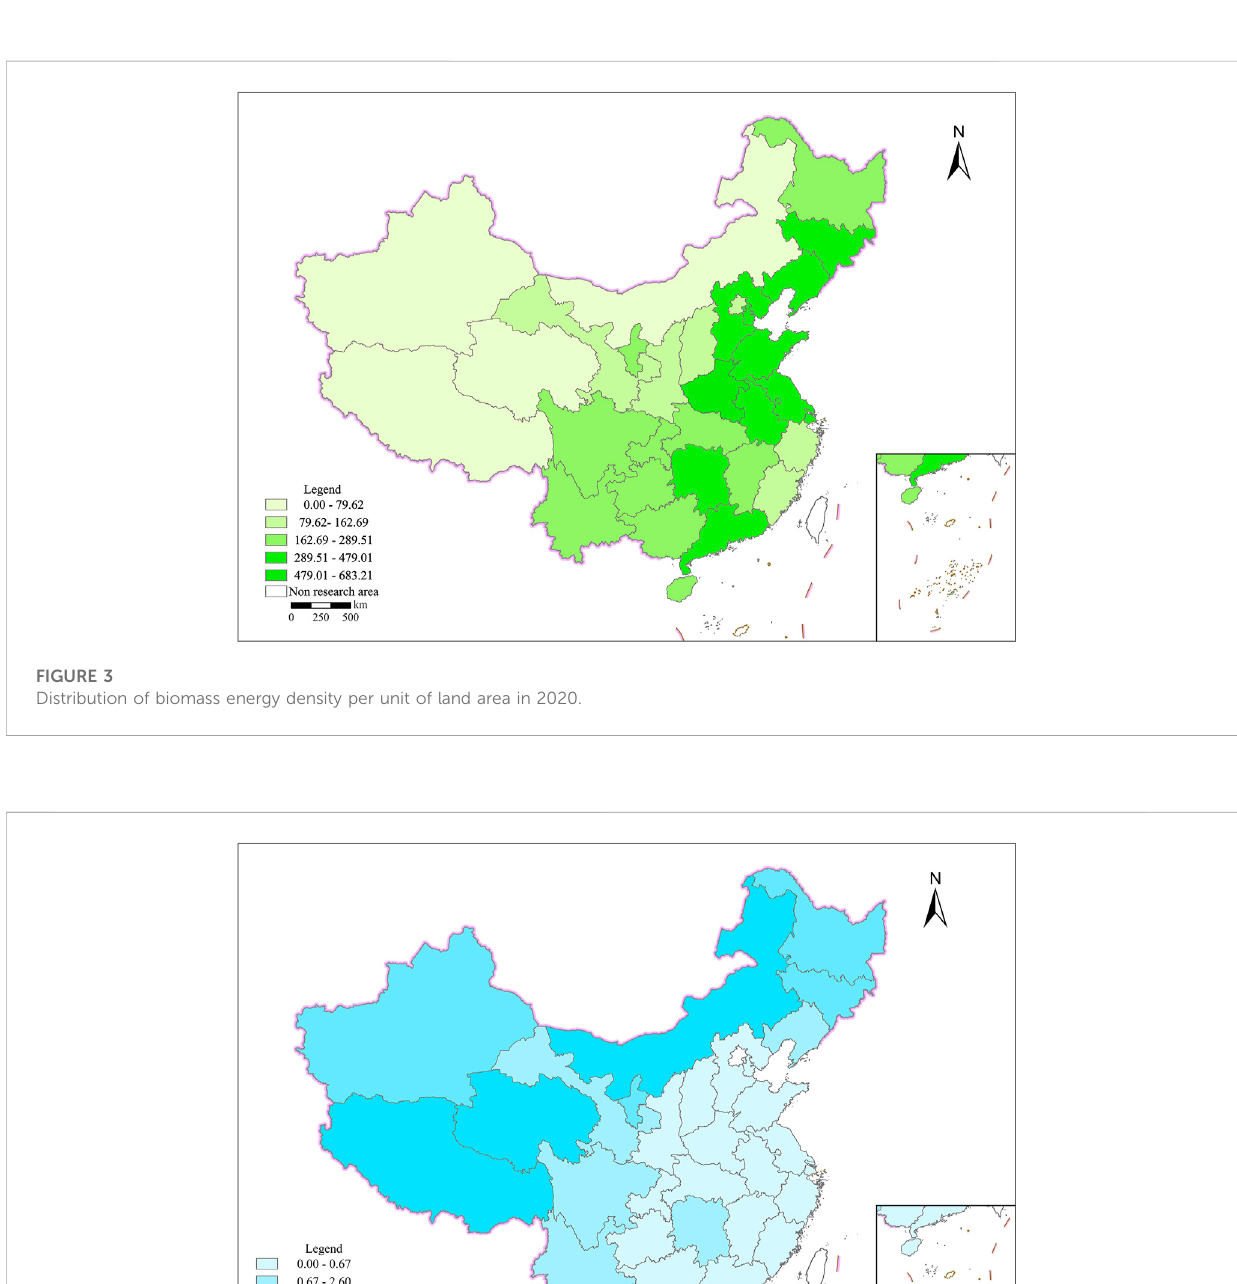
and southwest China, and concentrated in the provinces of City with a pattern of patchy distribution. The number of sub-hot spots surrounding hot spots is rising. By 2020, the sub-hot spots are distributed in two belts, extending eastward and westward. The cold spots are distributed in northwest and east China. In 2000, the most prominent cold spots were in Gansu Province. The sub-cold spots